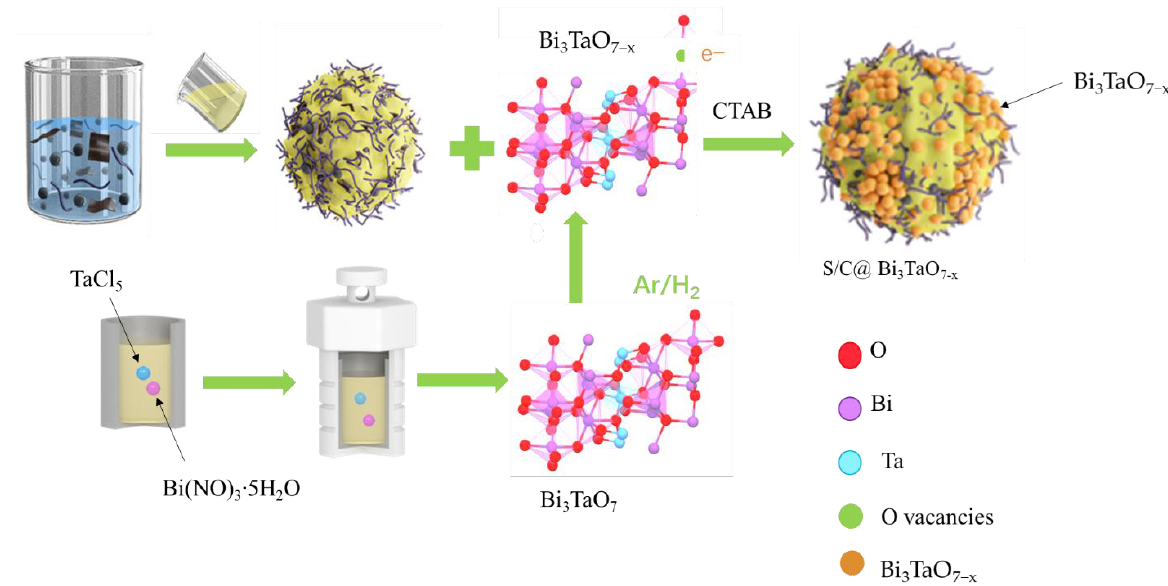
Figure 1. Schematic illustration of the synthesis of S/C@Bi 3 TaO 7−x .